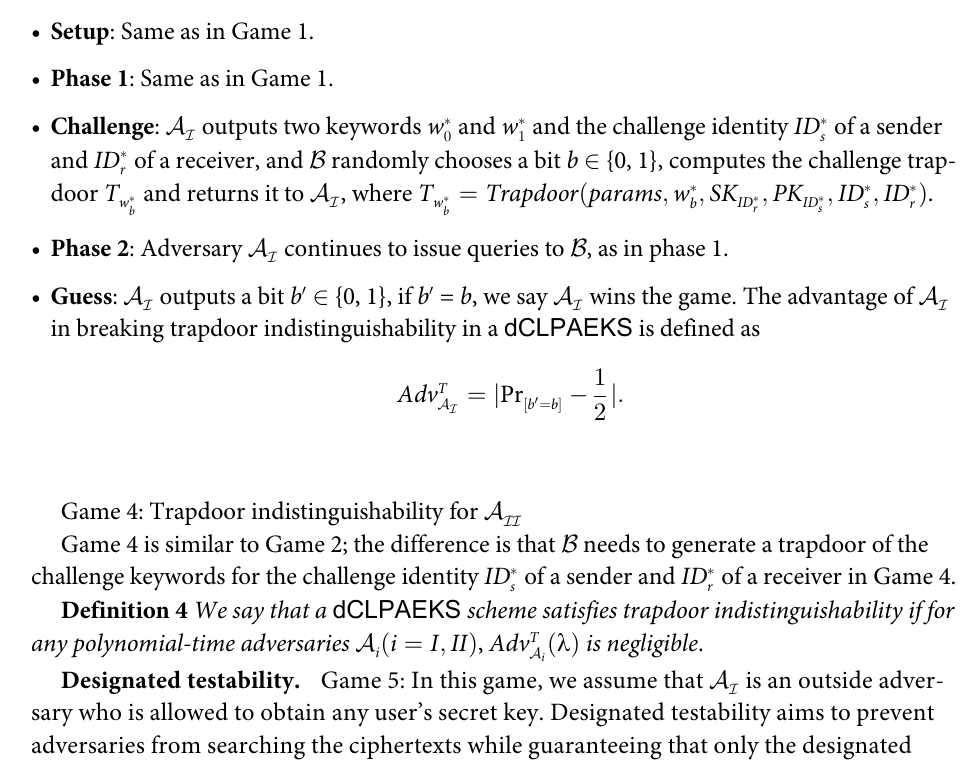
Game 4: Trapdoor indistinguishability for A